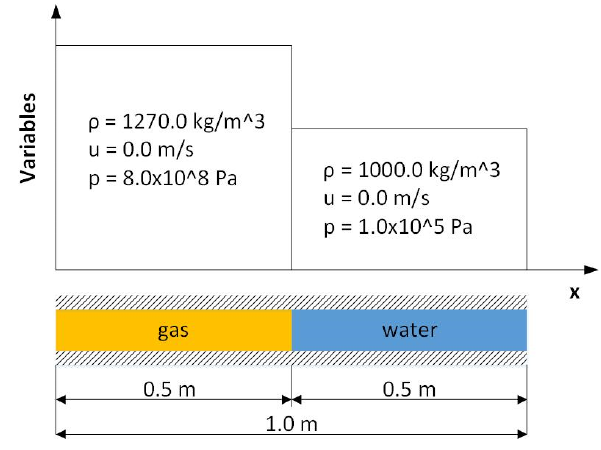
Figure 12. ICs of Case 2.